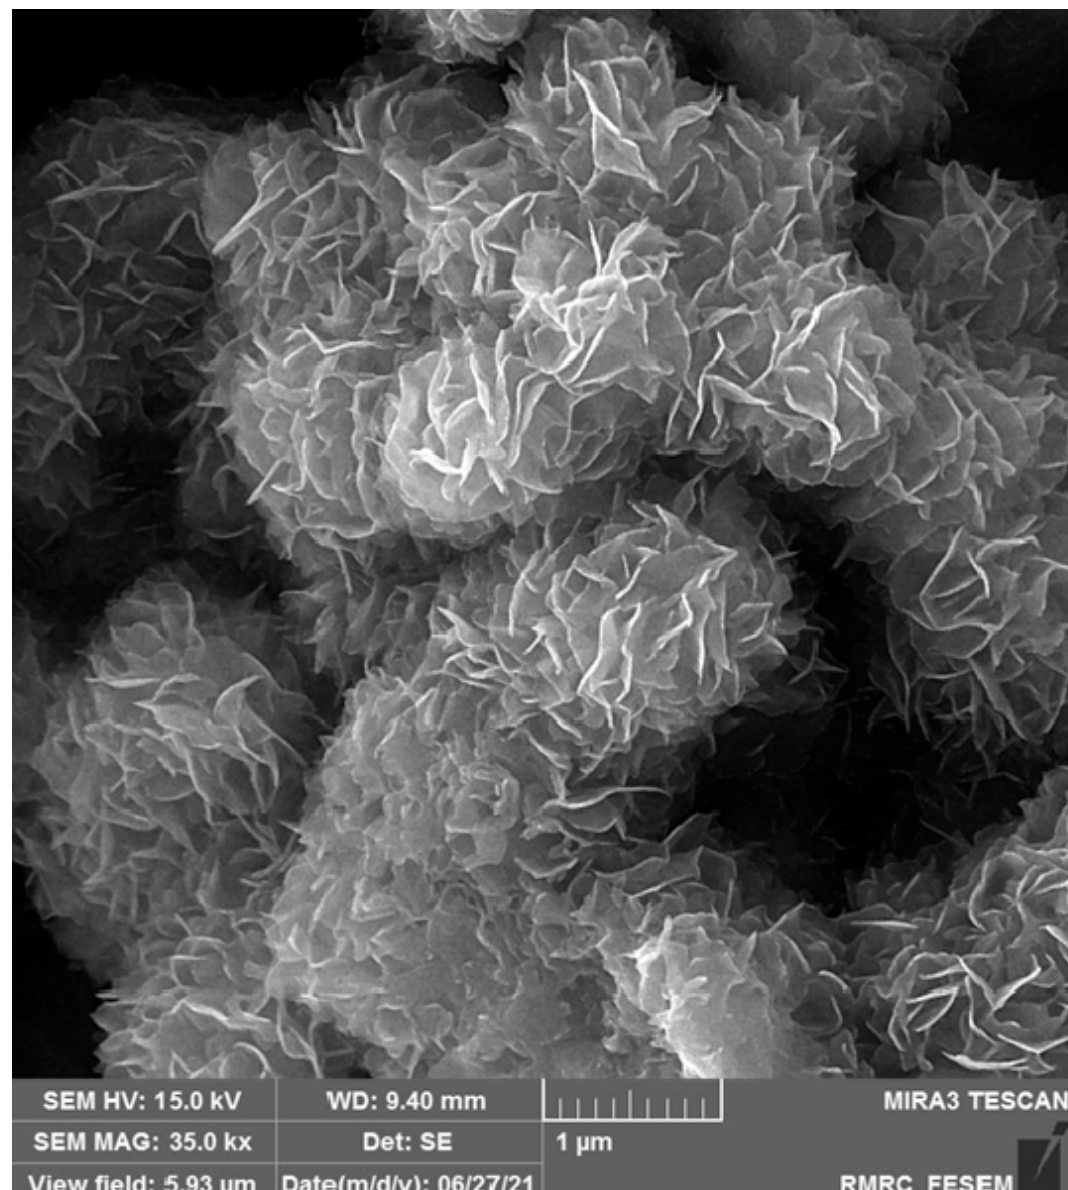
Figure 1. The SEM images captured for MoS 2 NSs.